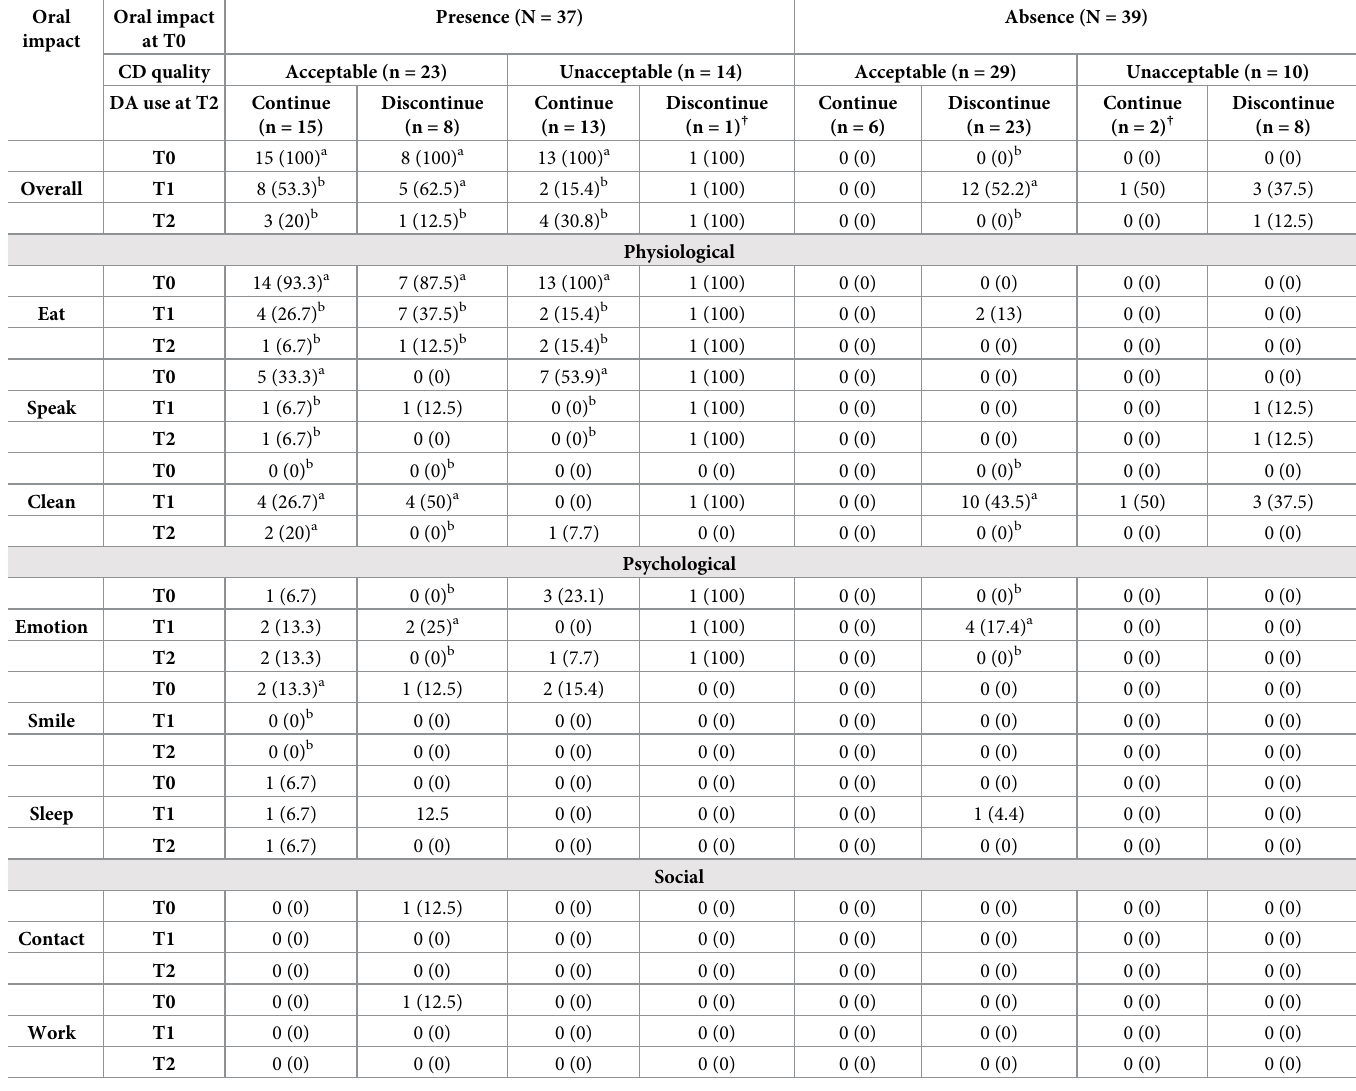
Table 2. Frequency (percentage) of the participants who had oral impact at each time